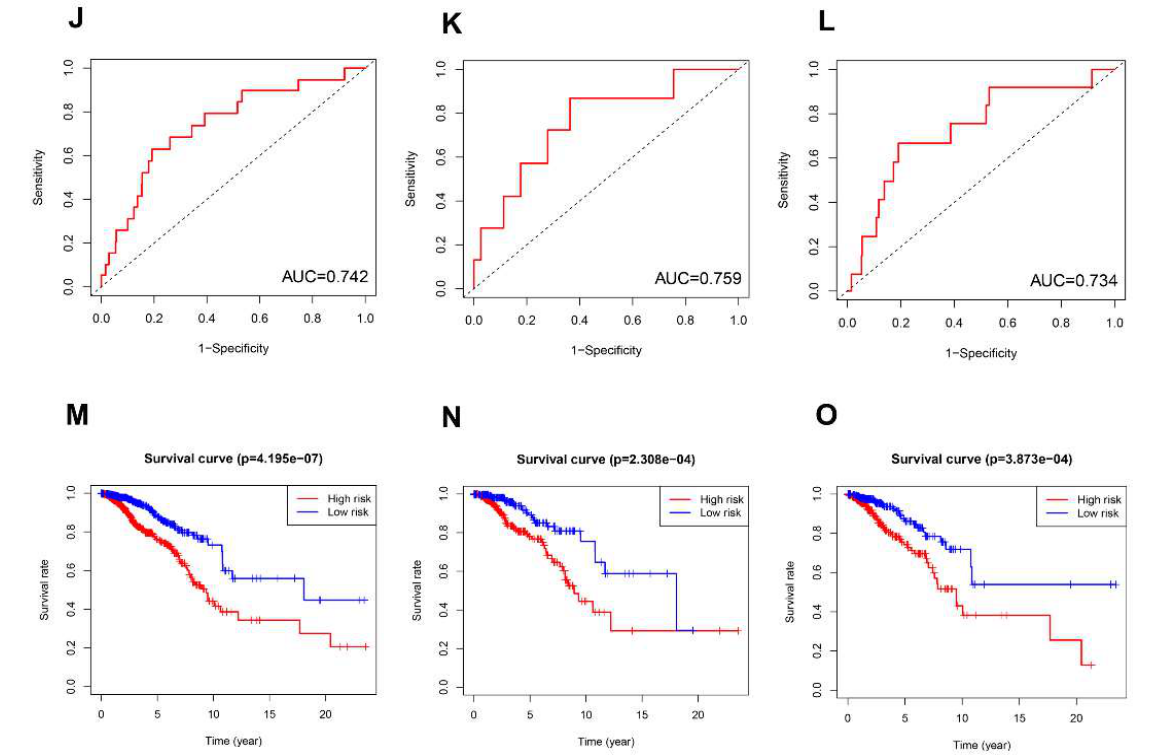
Figure 5. Risk model for AR-lncRNAs. ( A ) LASSO coefficient profiles of 17 prognostic AR-lncRNAs in the TCGA training cohort. ( B ) Through the LASSO regression model, AR-lncRNAs with the best discriminative power (10) were selected for establishing risk scores. ( C ) Correlations between risk scores and AR-lncRNAs in the model were determined using Spearman correlation analysis. ( D ) The nomogram model assesses the 1-, 3-, and 5-year survival probability of BC patients. ( E ) The 1-year, 3-year, and 5-year survival-rate calibration curves of the line chart. ( F ) TimeROC curves of nomograms, risk scores, and clinical characteristics in the TCGA dataset. ( G – I ) The BC patients were